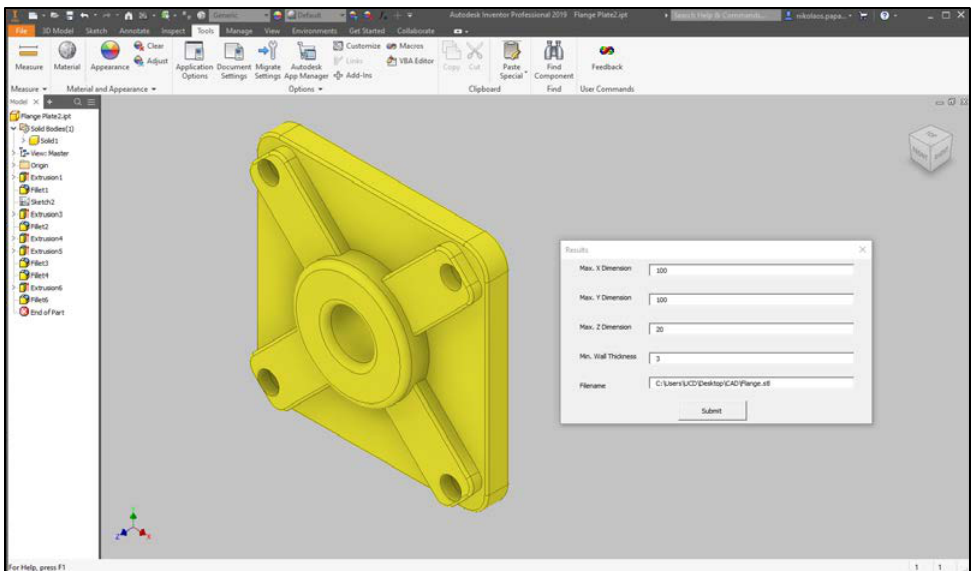
Figure 7. Test Case 1—Part geometry analysis tool integrated with a commercial Computer-Aided Design (CAD) system. Appl. Sci. 2020 , 10 , x FOR PEER REVIEW